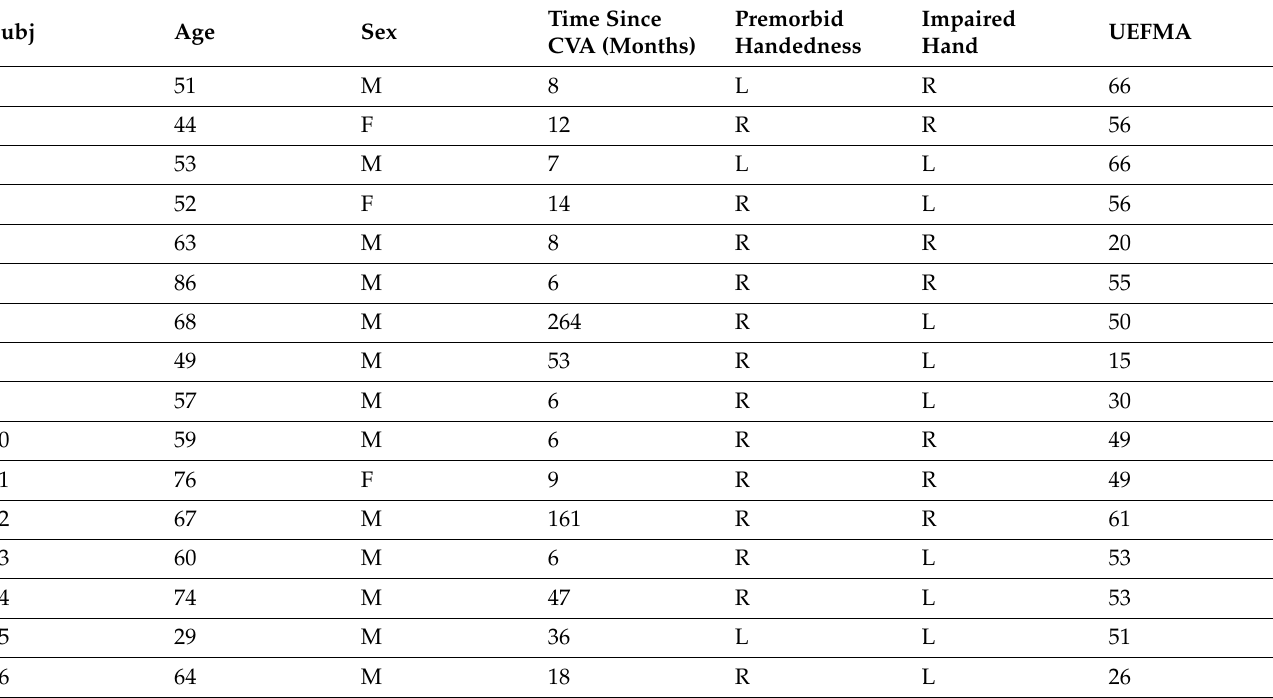
Table 3. Study #2 Subject Characteristics.